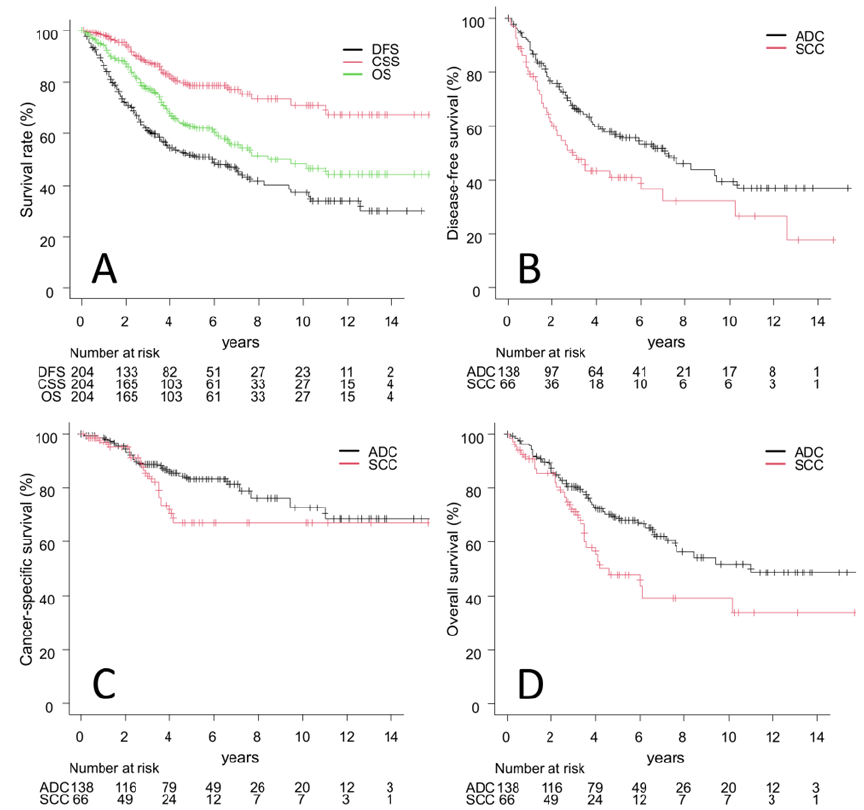
Figure 2. ( A ) Survival curves of disease-free survival (DFS), cancer-specific survival (CSS), and over- all survival (OS) in all patients. ( B − D ) Comparisons of DFS ( B ), CSS ( C ), and OS ( D ) between ade- nocarcinoma (ADC) and squamous cell carcinoma